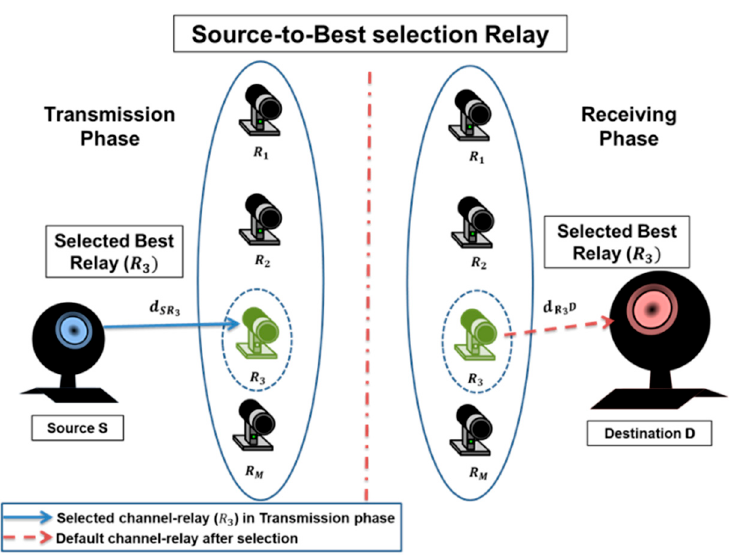
Figure 2. Source-relay Figure 2. Source ‐ relay scheme. Figure 2. Source ‐ relay scheme.